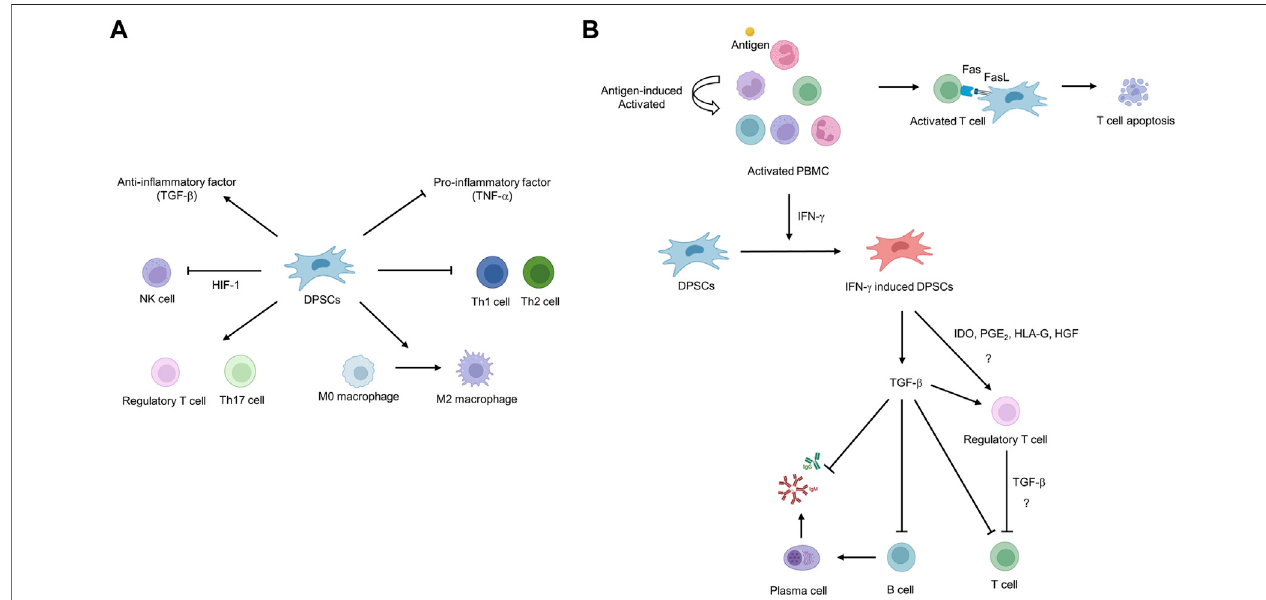
FIGURE3| Schematicdiagramoftheimmunosuppressivepotentialofdentalpulpstemcells(DPSCs). (A) DPSCscaninhibittheproliferationofnaturalkiller(NK),T helper 1 (Th1), and T helper 2 (Th2) cells and the secretion of pro-in fl ammatory factors such as TNF- α . In addition, DPSCs induce the proliferation of regulatory T cells (Tregs)/T helper 17(Th17) cells and differentiation toward macrophage M2phenotype and secrete anti-in fl ammatoryfactors such as TGF- β . (B) Fas ligand expressed in DPSCs induces T-cell apoptosis through Fas apoptotic pathway. IFN- γ secreted from hyper-activated T cells primes DPSCs to secrete TGF- β , resulting in immunosuppressive